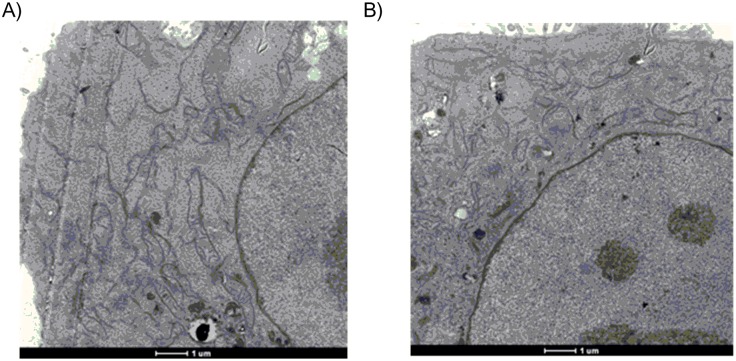
TEM images at 20 nm zoom of: a) glc-IONP-treated cells; b) PVP-IONP-treated cells.